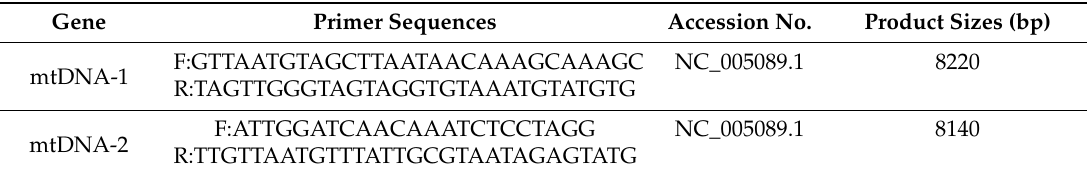
Table 2. Primer sequences and their corresponding PCR product sizes for long PCR.